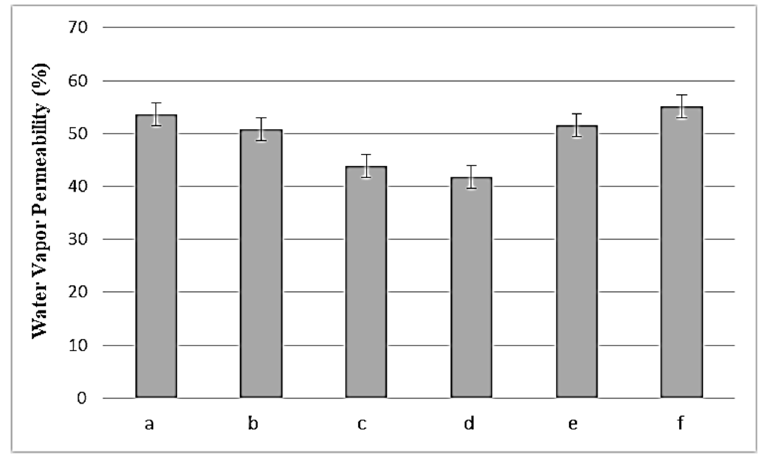
Figure 7. Water vapor permeability values for each specimen versus % content in CaCl 2 based on one-way ANONA ( p < 0.01). a: untreated; b: 10 wt % CaCl 2 ; c: 25 wt % CaCl 2 ; d: 50 wt % CaCl 2 ; e: 5 washes for b samples; f: 10 washes for b samples. The data are represented as mean ± SD.